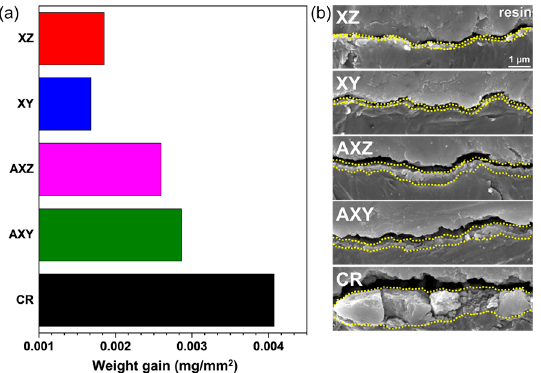
Figure 6. High-temperature oxidation of each specimen at 700 °C for 24 h. ( a ) Weight gain and ( b ) cross-sectional morphology of oxide layer.